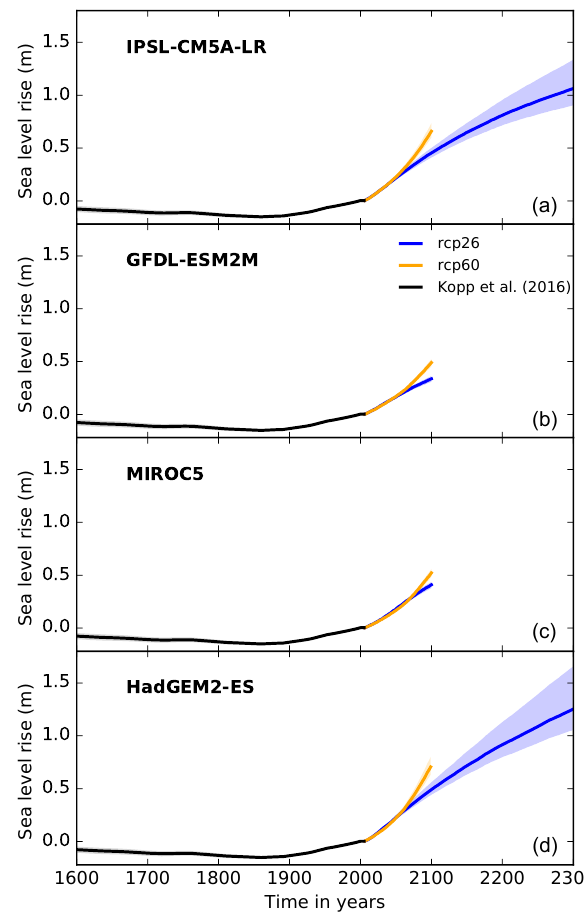
Figure 4. Time series of global total sea-level rise based on observations (Kopp et al., 2016, black line) until year 2005 and global-mean-temperature change from IPSL-CM5A-LR (a) , GFDL-ESM2M (b) , MIROC5 (c) , and HadGEM2-ES (d) after year 2005: solid lines: median projections, shaded areas: uncer- tainty range between the 5th and 95th percentile of the uncertainty distribution associated with the ice components. Blue: RCP2.6, yel- low: RCP6.0. All time series relative to year 2005. Non-climate- driven contribution from glaciers and land water storage are added to the